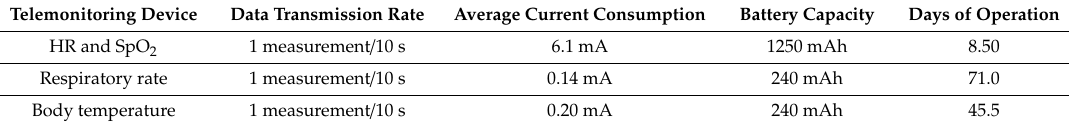
Table 1. Data transmission rate, energy consumption, and battery life.